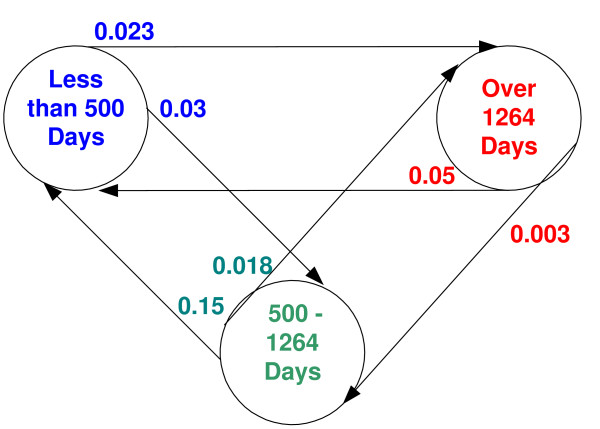
The different types of errors of the best FLP (FLP1). The number on an arrow from state x to state y is the probability that the predictor miss-classify a patient whose true state is x and will put it in state y. This is an extension of the widely used two states sensitivity and specificity measures.